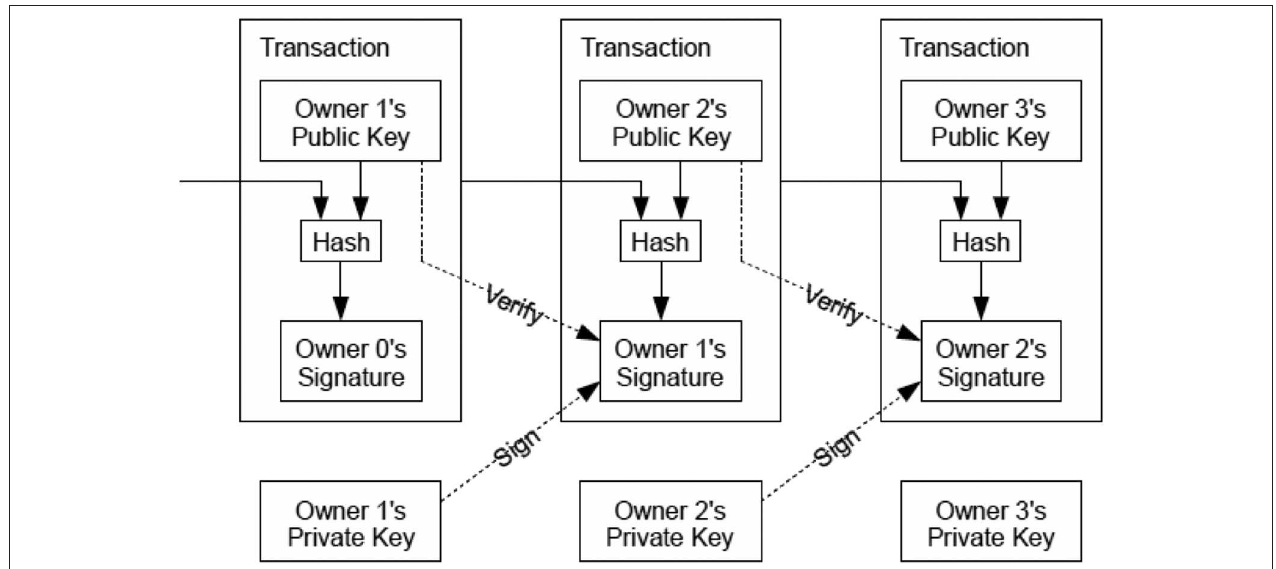
FIGURE 1 | A blockchain as implemented by